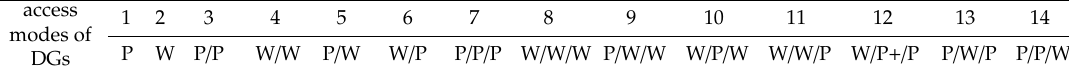
Table A2. Di ff erent access modes of distribution